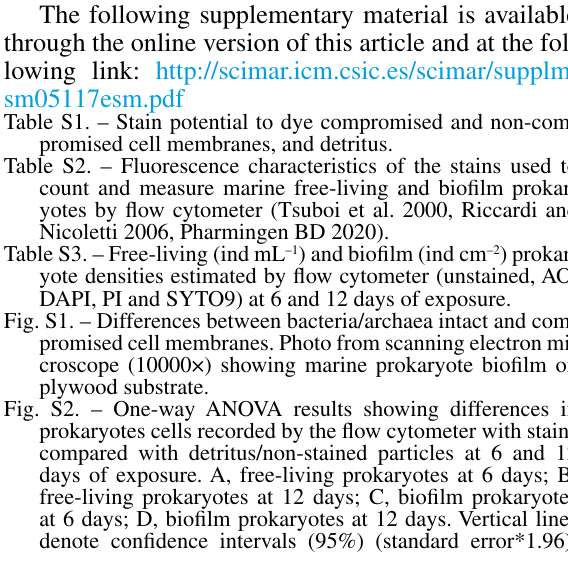
Table S2. – Fluorescence characteristics of the stains used to count and measure marine free-living and biofilm prokar- yotes by flow cytometer (Tsuboi et al. 2000, Riccardi and Nicoletti 2006, Pharmingen BD 2020). Table S3. – Free-living (ind mL –1 ) and biofilm (ind cm –2 ) prokar- yote densities estimated by flow cytometer (unstained, AO, DAPI, PI and SYTO9) at 6 and 12 days of exposure. Fig. S1. – Differences between bacteria/archaea intact and com- plywood substrate. Fig. S2. – One-way ANOVA results showing differences in prokaryotes cells recorded by the flow cytometer with stains compared with detritus/non-stained particles at 6 and 12 days of exposure. A, free-living prokaryotes at 6 days; B, free-living prokaryotes at 12 days; C, biofilm prokaryotes at 6 days; D, biofilm prokaryotes at 12 days. Vertical lines denote confidence intervals (95%) (standard error*1.96).